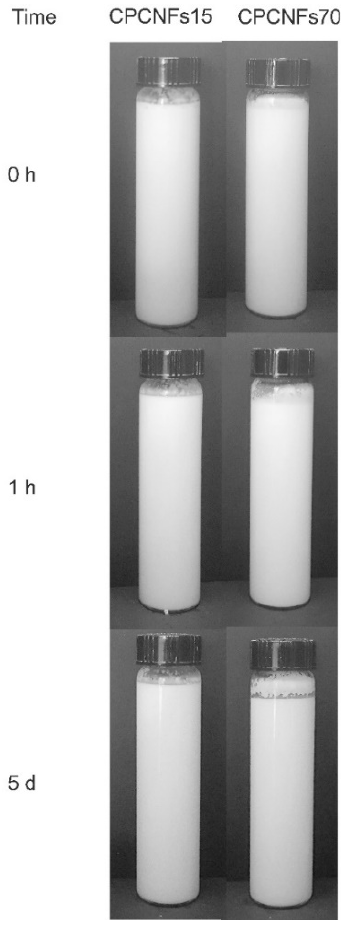
Figure 4. Emulsions processed with coconut oil and 0.6 wt.% of polysorbate 80 with 0.15 (CPCNFs15) and 0.7 wt.% (CPCNFs70) of CNFs, after 0 h, 1 h and 5 days of static storage.